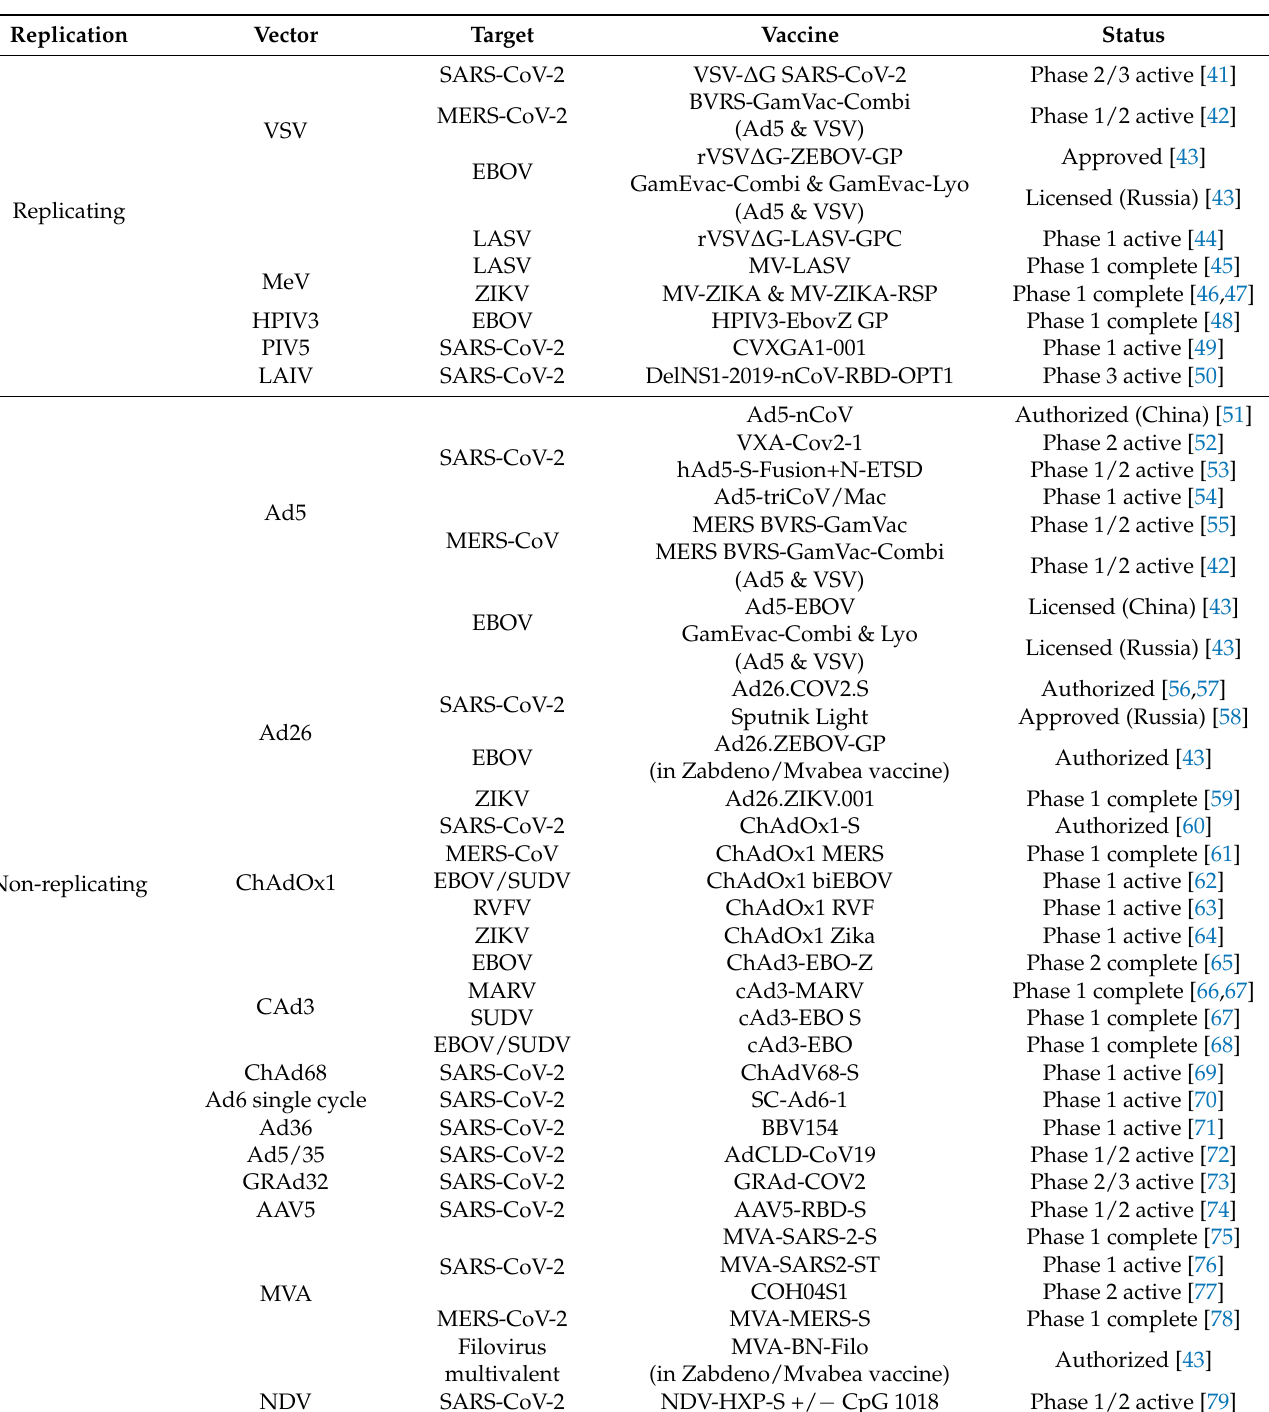
Table 3. Approved and clinical-stage viral vector vaccine candidates for viruses of